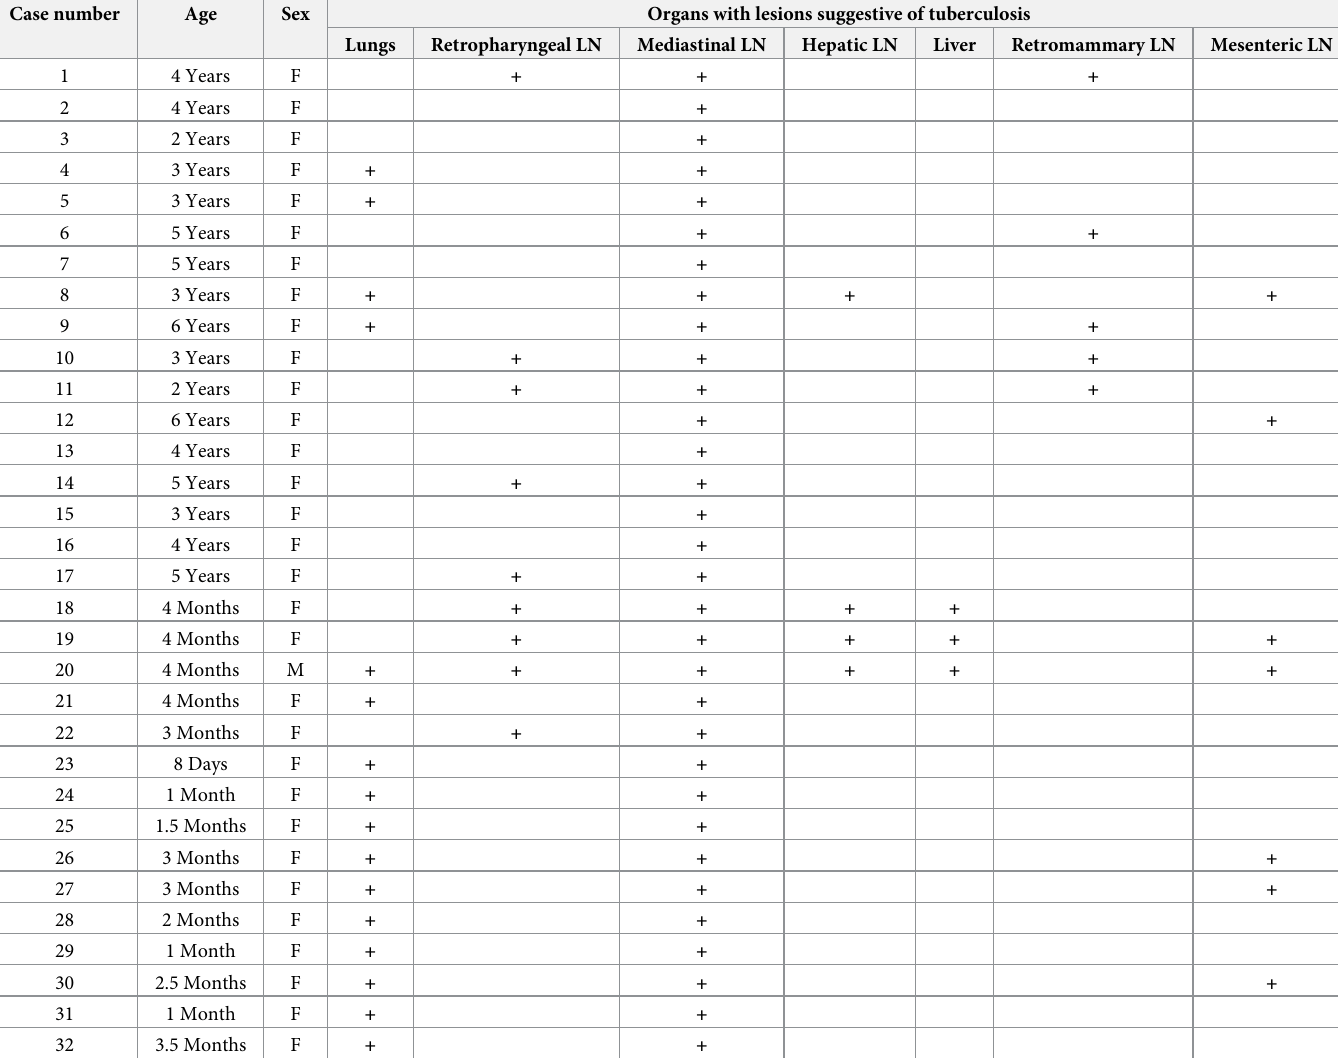
Table 1. Distribution of granulomatous lesions in cattle naturally infected with M . bovi